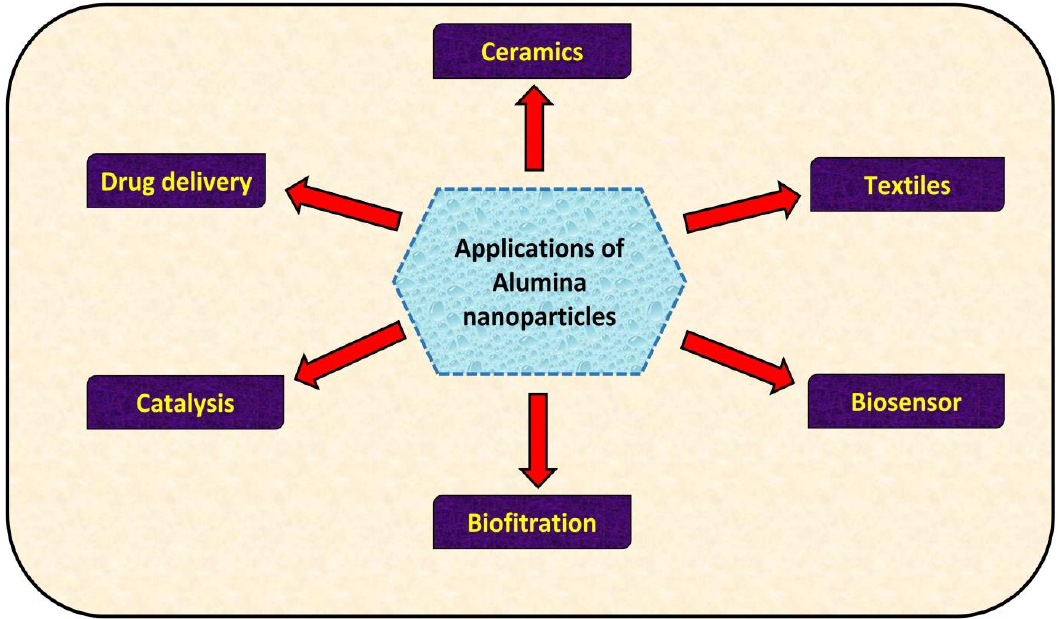
Fig. 1. Various applications of Al Figure 1. Various applications of Al 2 O 3 NPs